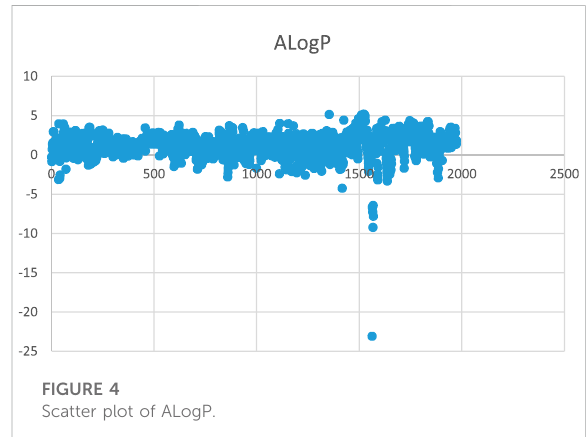
FIGURE 4 Scatter plot of ALogP.